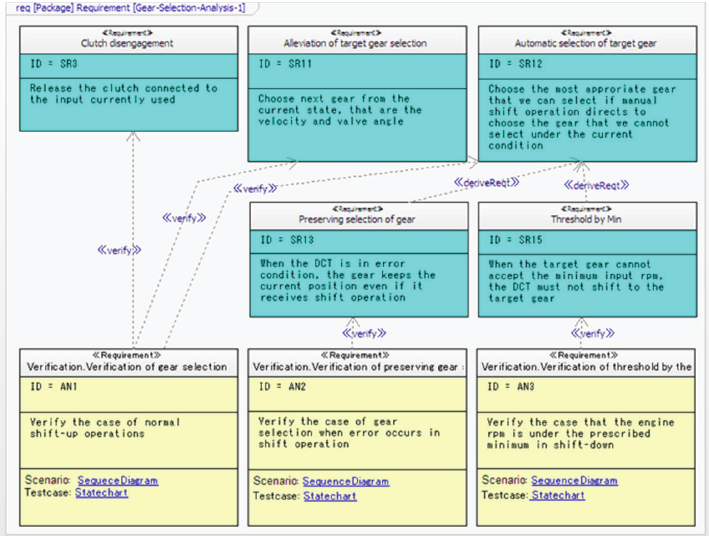
Figure 17: Verification items.